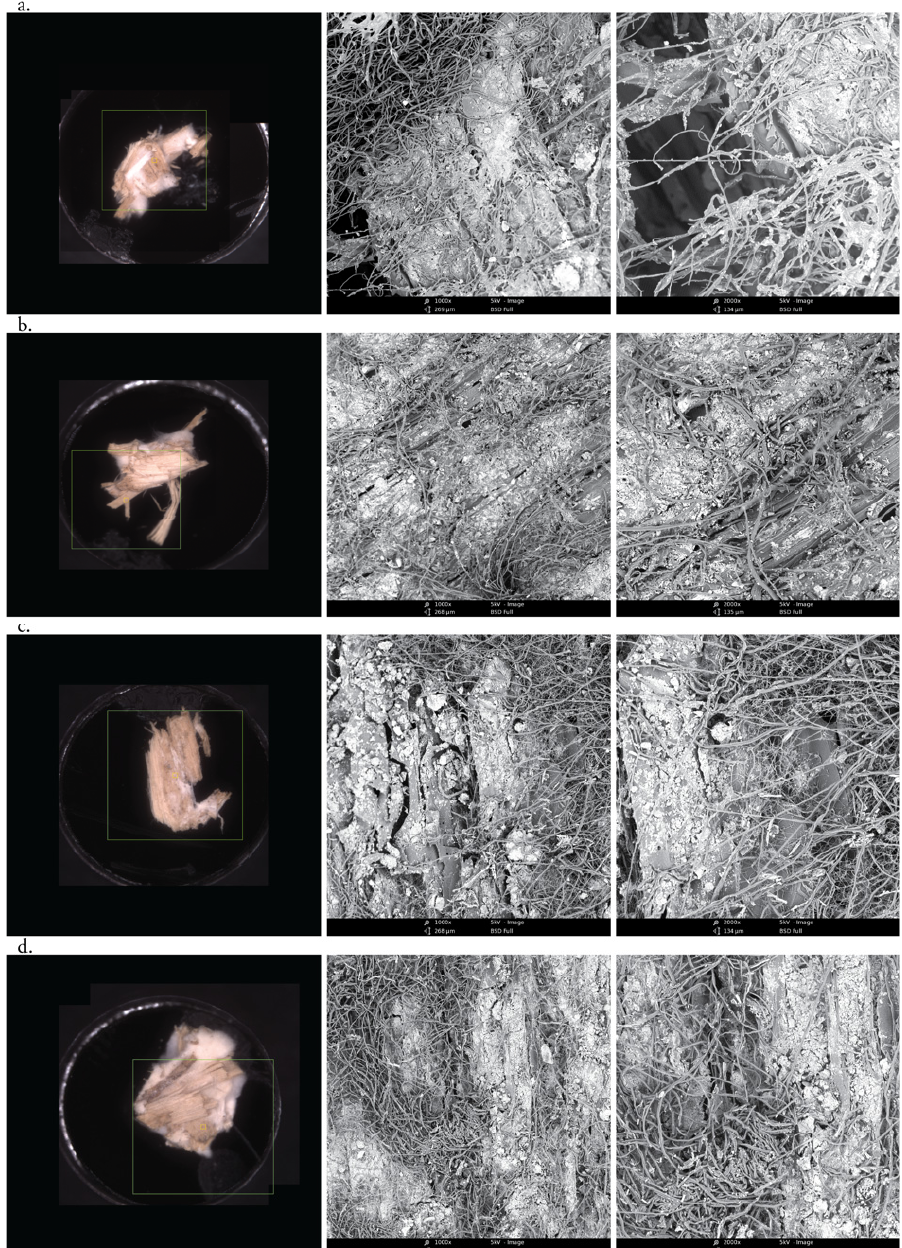
Figure 5. Morphological characterization by SEM images of T. versicolor (long threads) on a hemp (dark-gray, plate-like fibers) and nanoclay (light-gray particles) substrate after 7 days. ( a ) 1 wt.% nanoclay. ( b ) 2.5 wt.% nanoclay. ( c ) 3.5 wt.% nanoclay. ( d ) 5 wt.% nanoclay. Micrographs were taken at zoom 10 × , zoom 1000 × and zoom 2000 ×